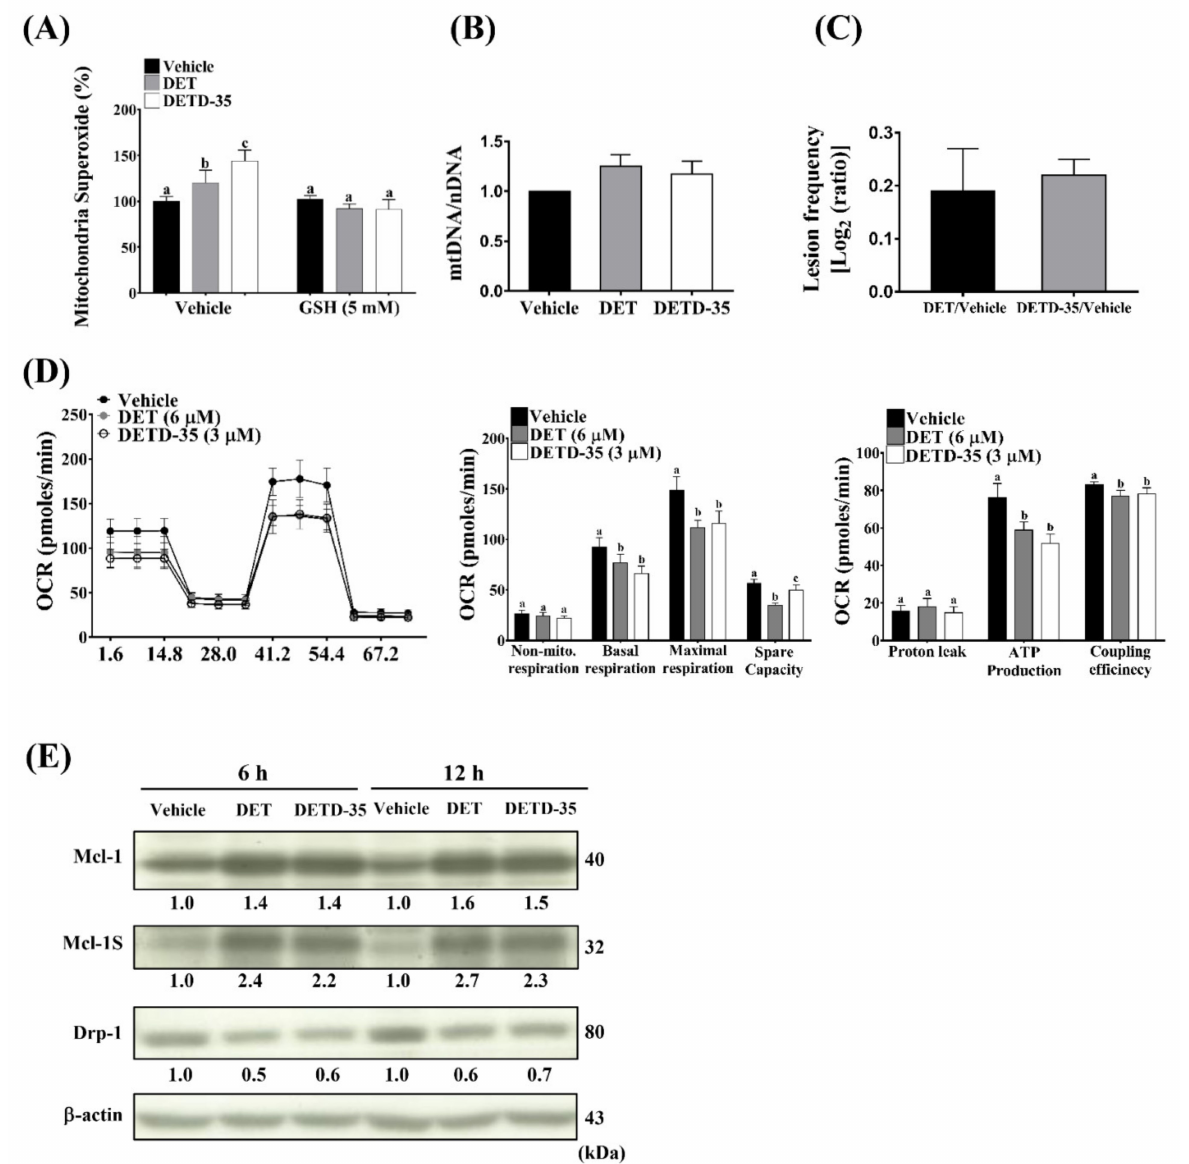
Figure 5. DET and DETD-35 induced mitochondrial dysfunction in A375LM5 IF4g/Luc melanoma cells. ( A ) The A375LM5 IF4g/Luc cells were pre-treated with/without GSH (5 mM) for one hour and then incubated with DET (6 µ M) or DETD-35 (3 µ M) for one hour in the presence of the mitochondria superoxide indicator MitoSox Red, and the levels of superoxide were detected by flow cytometry. ( B , C ) The A375LM5 IF4g/Luc cells were treated with DET (6 µ M) or DETD-35 (3 µ M) for 6 h, the genomic DNA was isolated, and PCR products for nuclear and mitochondrial DNA were detected and quantified by agarose gel electrophoresis and ImageJ. The mitochondria mass was calculated by the formula mtDNA/nDNA, and the mtDNA lesion frequency was calculated by the formula: -LN((Large fragment/short fragment)/(average of